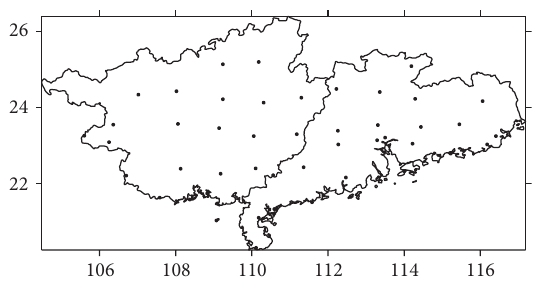
Figure 1: Locations of meteorological stations (dots) providing precipitation